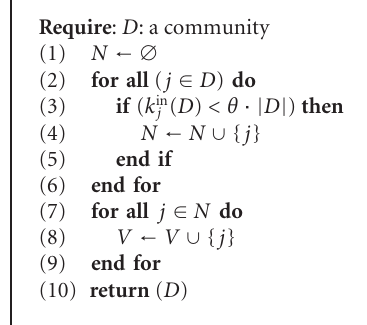
Algorithm 2: Procedure FilterSubConnected( θ ).